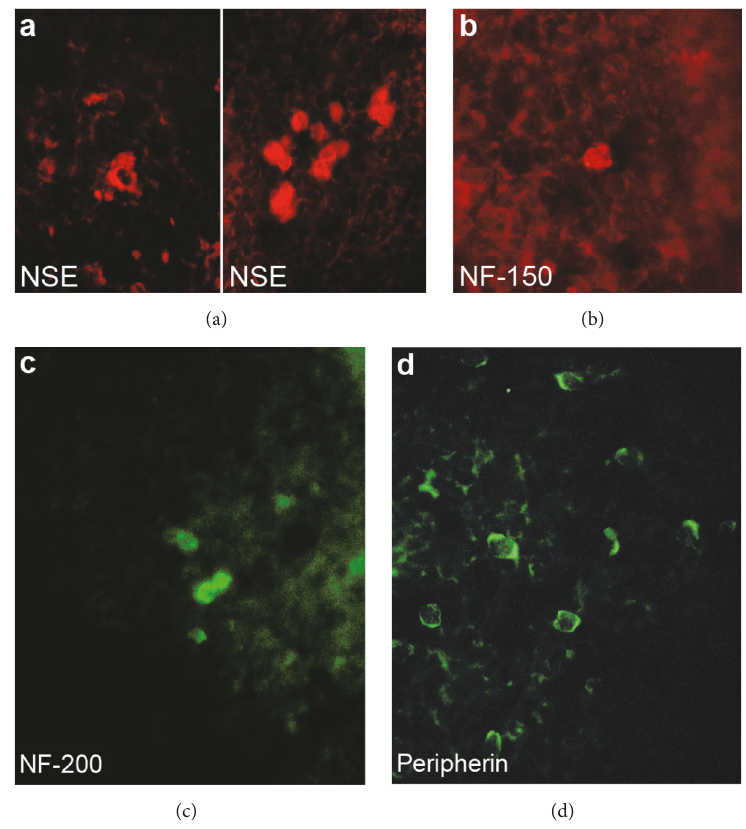
Figure 4: Expression of neuralcellmarkers in the mousespleen. NSE (a), NF-150(b), NF-200(c),and peripherin (d) staining was observed in the perivascular region of the white pulp and the subcapsular region. They were round, with a 10 𝜇 m diameter and no recognizable